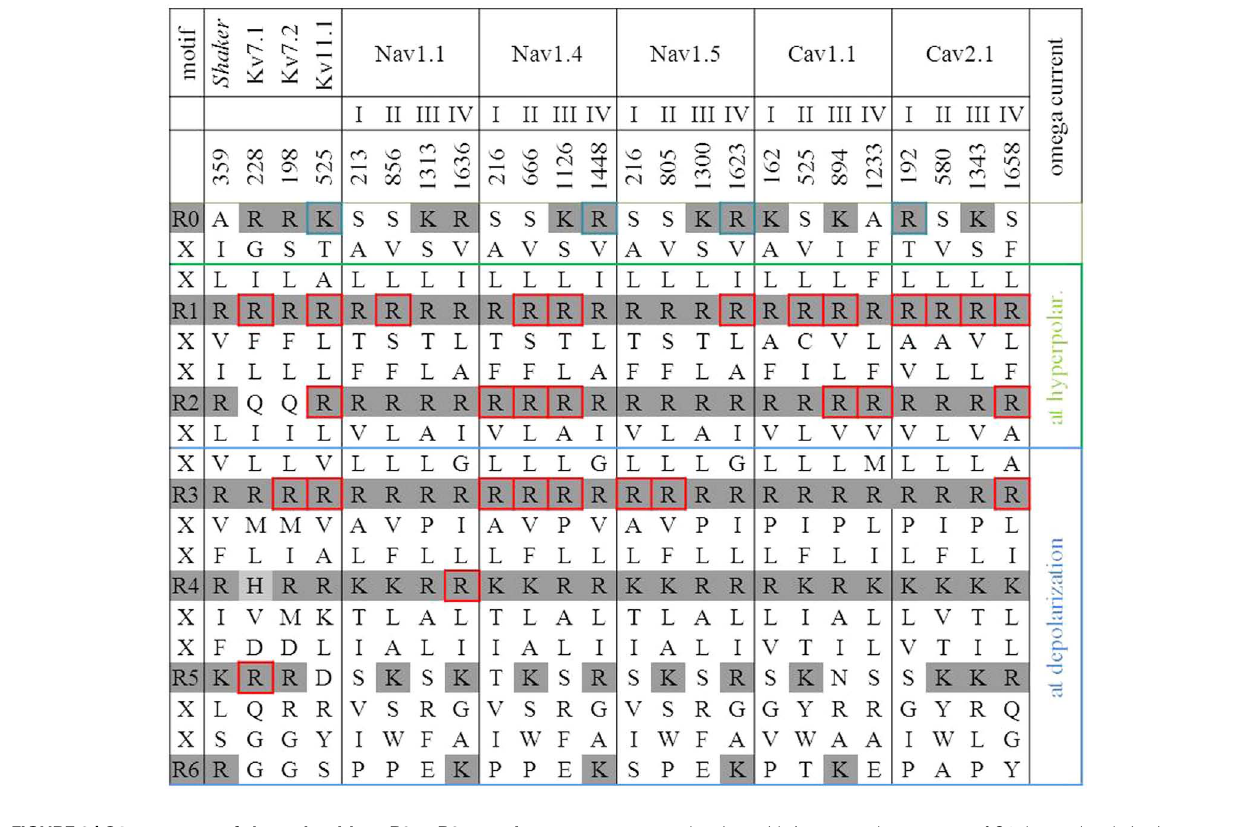
An outward movement of S4 due to depolarization opens the omega pore if R3 or R4 is replaced by a neutral amino acid. These gray-background arginines are boxed.The Shaker K + channel serves as reference. Neutral replacements of its arginines R2 and R3 have been described as proton